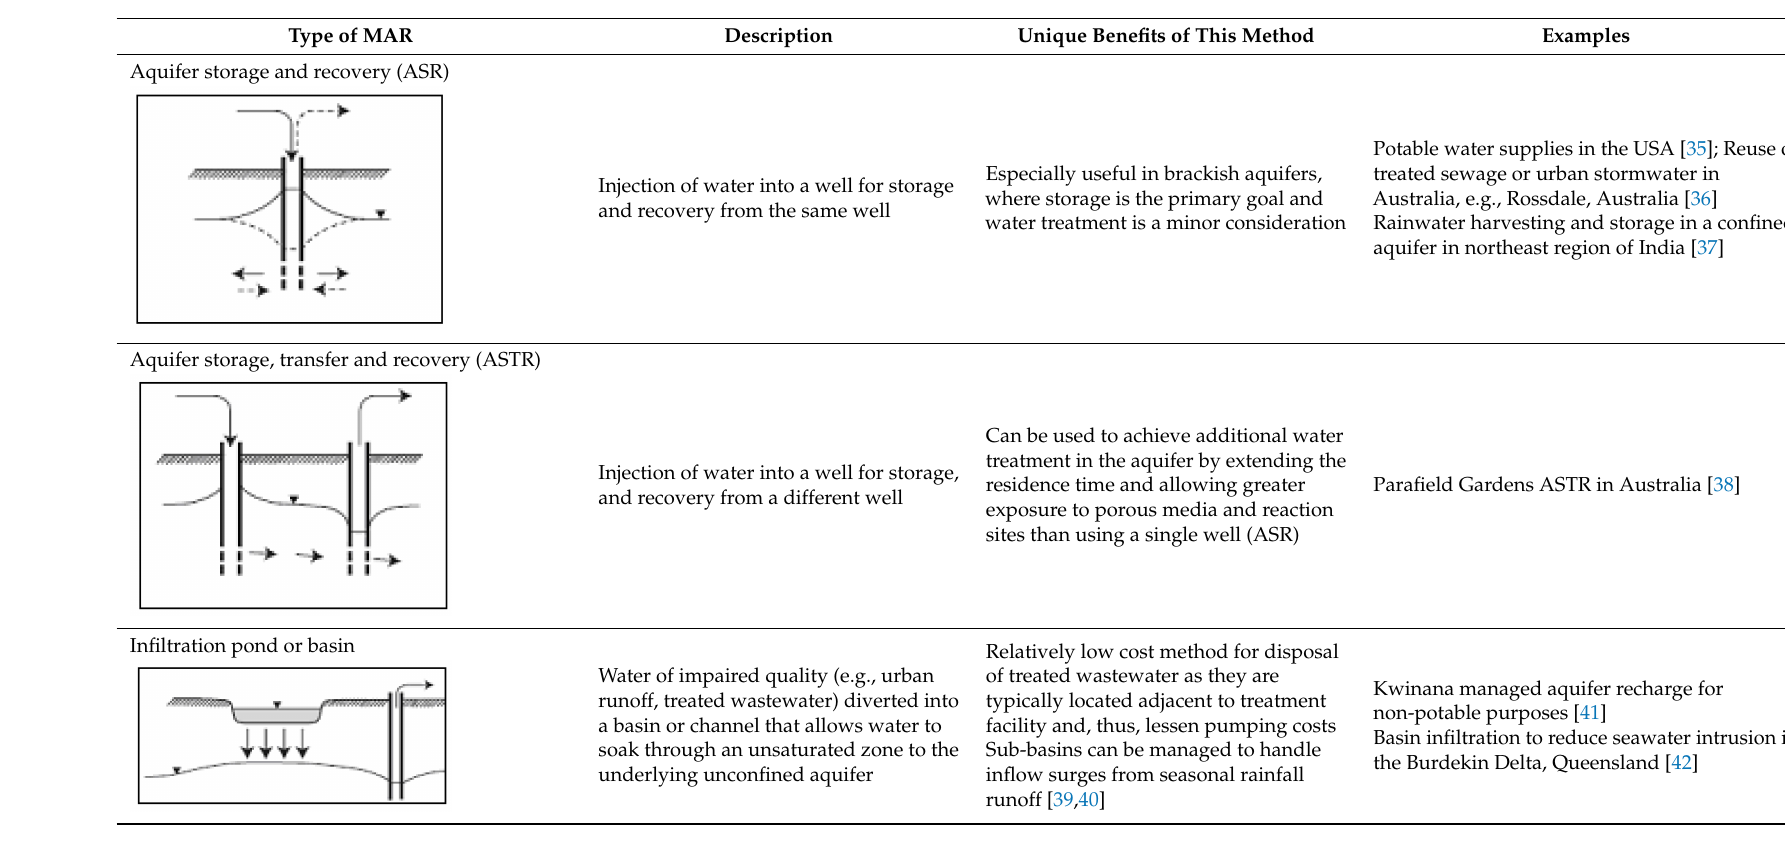
Table 2. Summary of common types of MAR. Diagrams are modified after Dillon 2005 [31]. Reprinted by permission from Springer Customer Service Centre